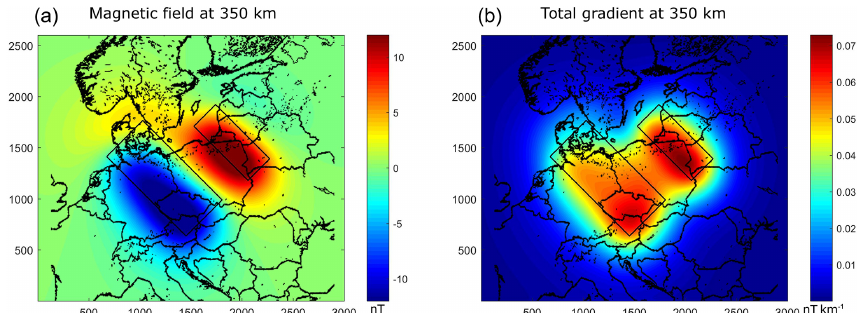
Figure 10. Magnetic field (a) and total gradient intensity (b) from a synthetic model of central Europe in agreement with Taylor and Ravat (1995). This model refers to hypothesis A described in this paper. Reverse magnetization is assigned to central European crust and normal magnetization to the Precambrian platform. The magnetic field anomaly is computed at 350km of altitude (a) . The total gradient intensity map (b) shows two highs above both the synthetic